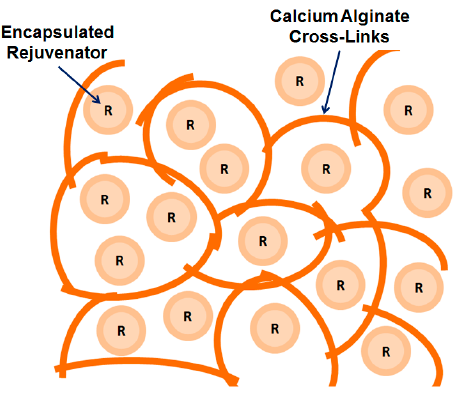
Figure 1. Rejuvenator encapsulated by the calcium alginate crosslinks.